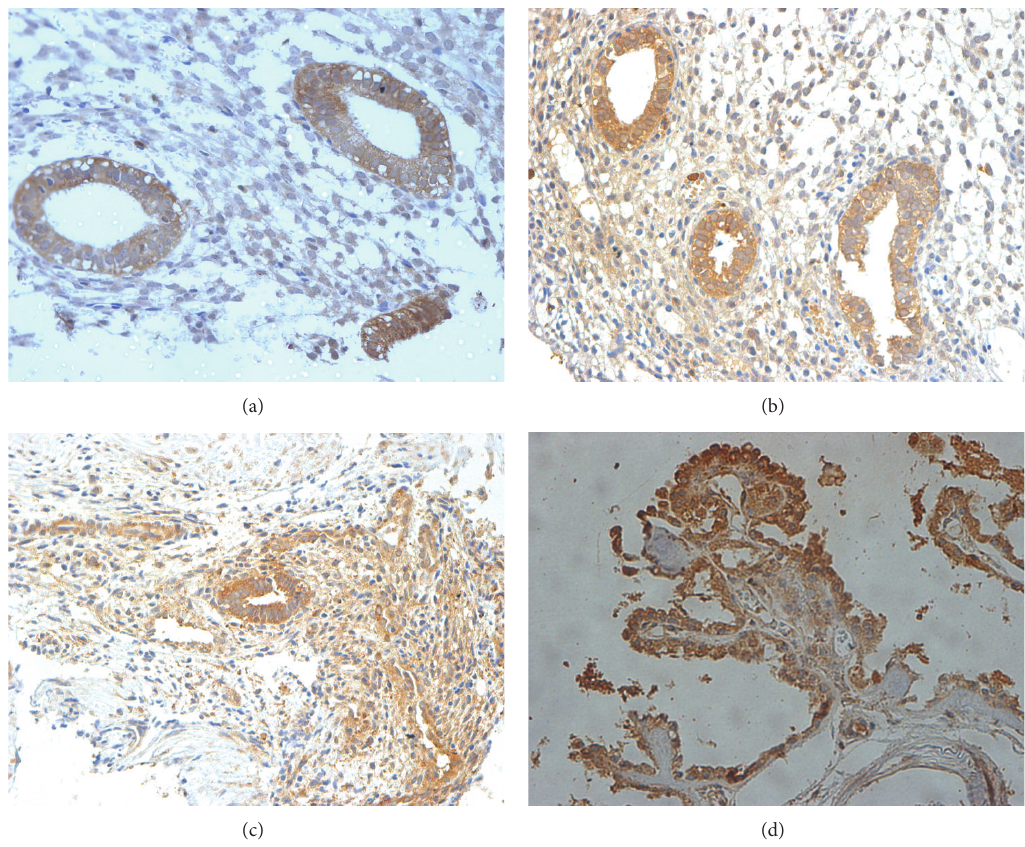
Figure 2: Immunostaining of long leptin receptor isoform (OB-R L ) in eutopic endometrium. (a) Non-endometriosis controls, (b) eutopic and (c) ectopic endometria of patients with endometriosis, and (d) positive control (choroid plexus). Original magnification: 400